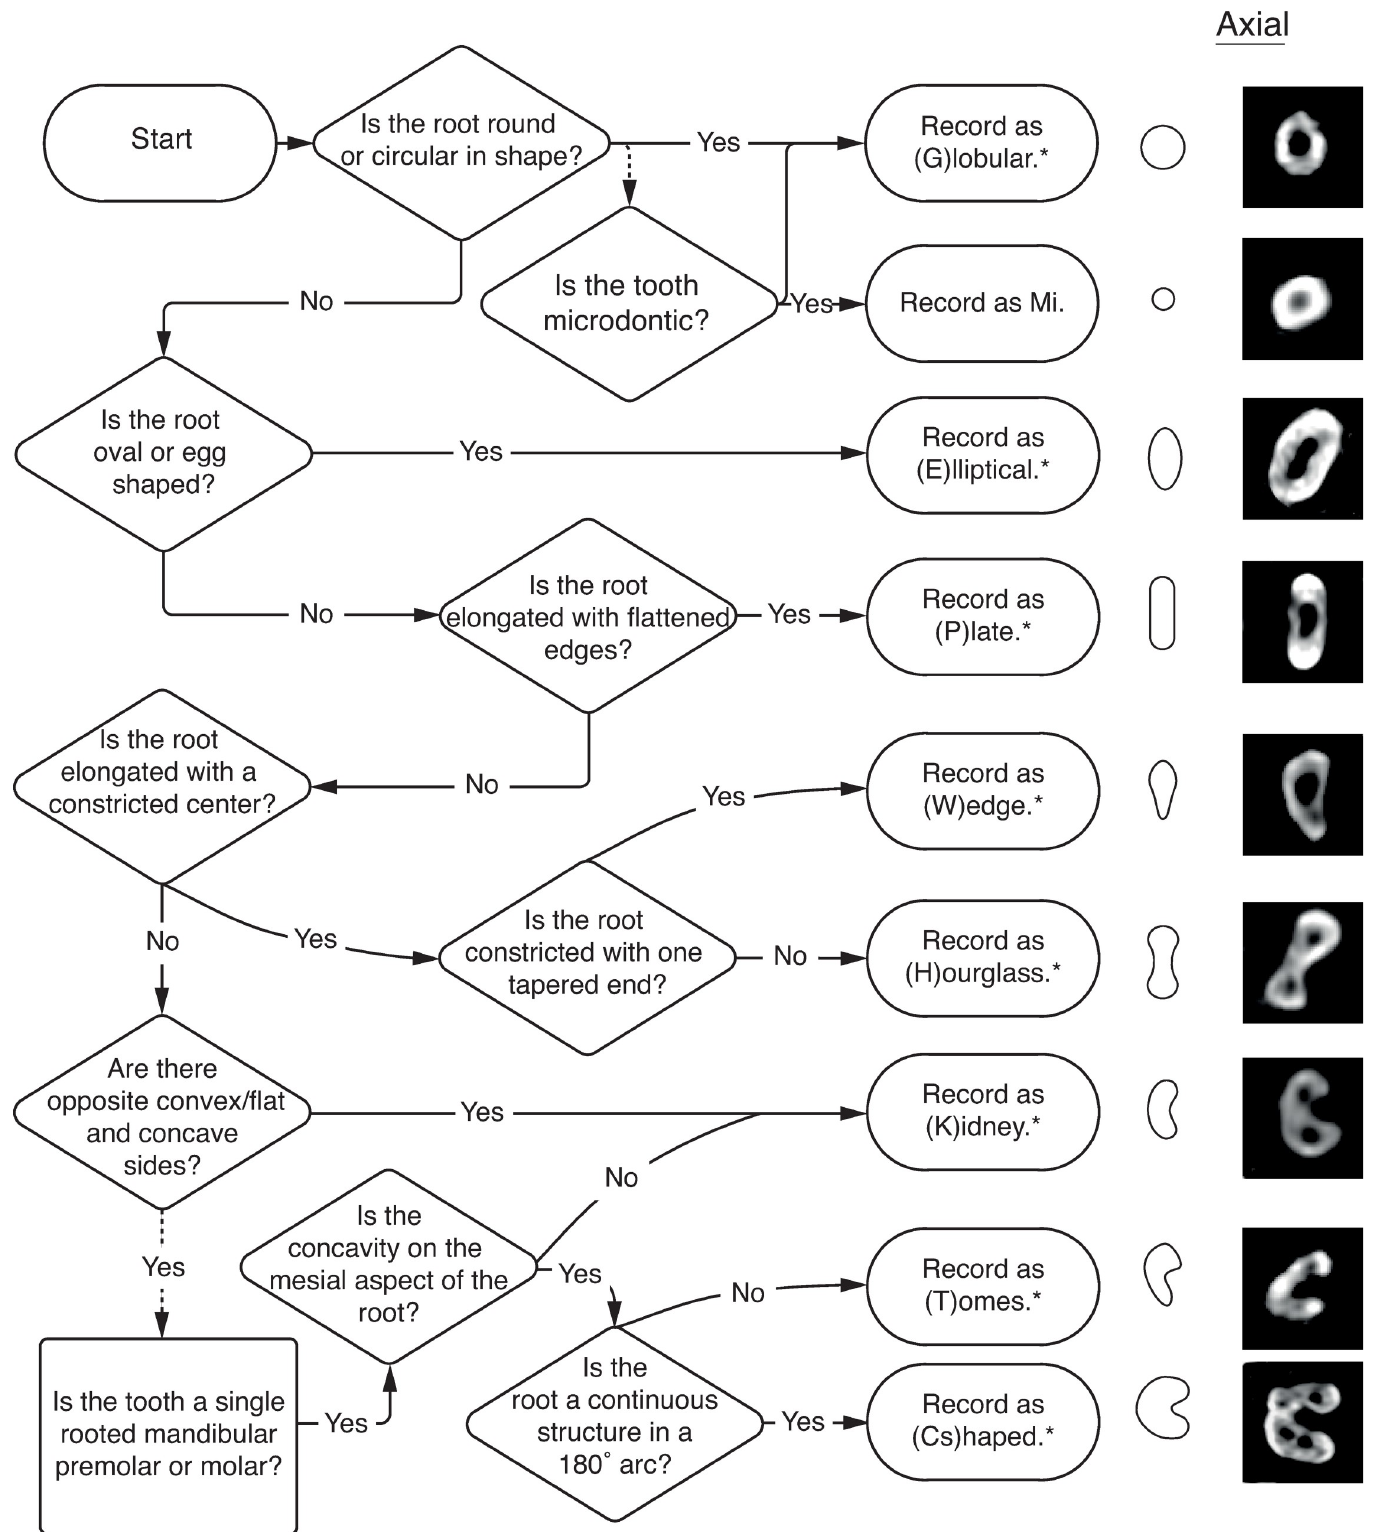
Fig 16. Flow chart for determining and recording phenotype element 4—external root morphology. � if root is bifurcated, append morphology with Bi. Ex: P = plate, PBi = plate-bifurcated. Right: axial CT slices showing external root morphologies.